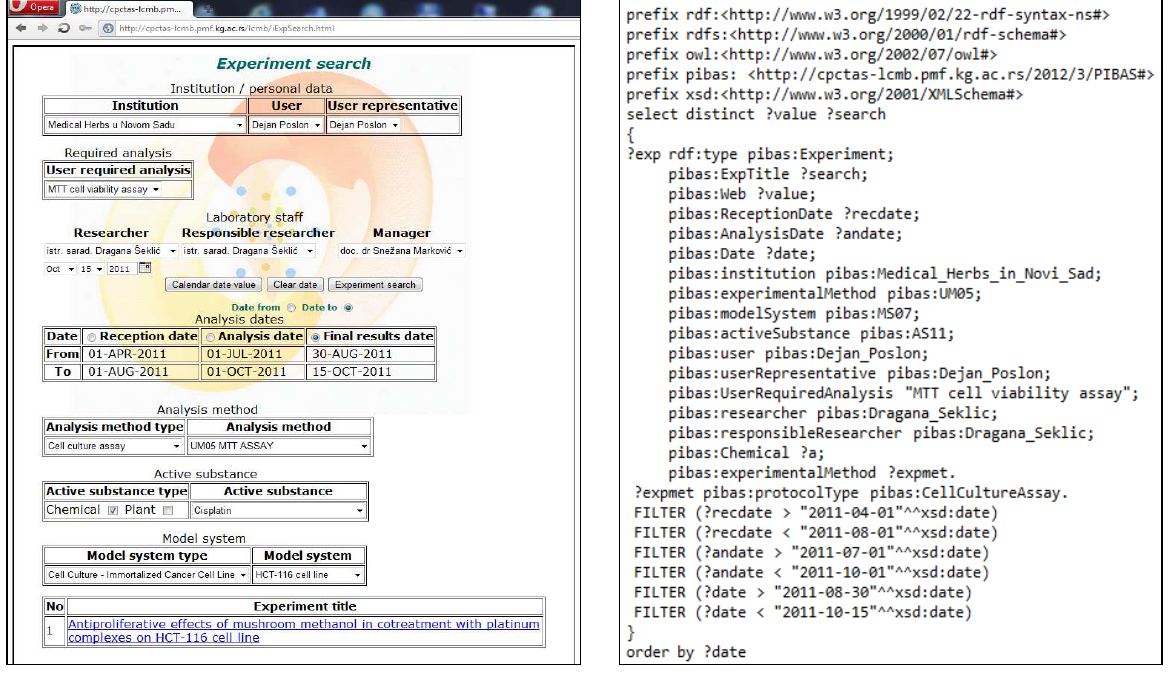
Figure 12. Experiment search result for all selected search